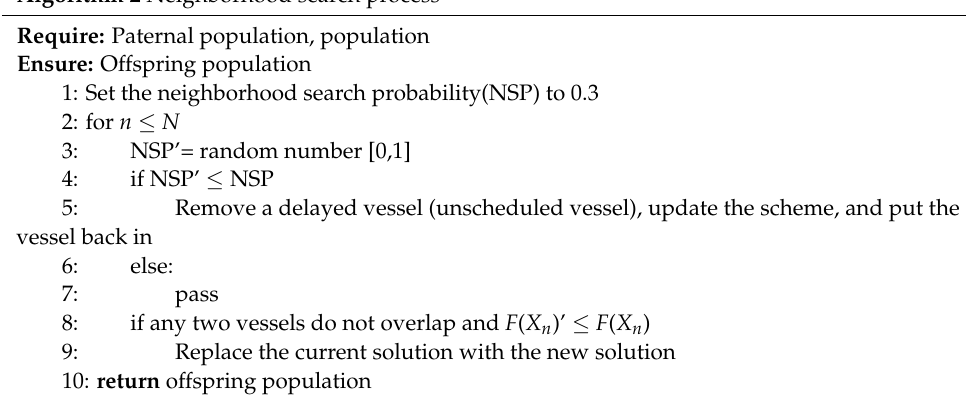
Algorithm 2 Neighborhood search process